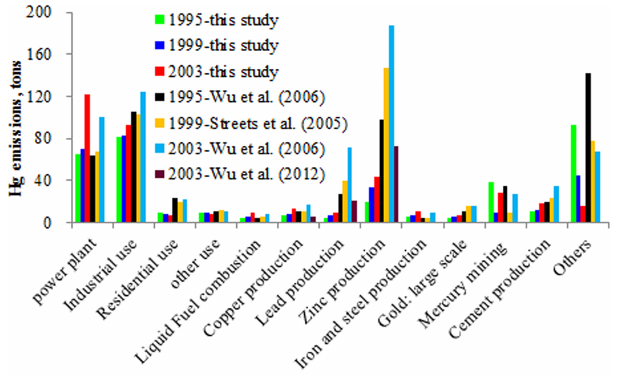
Figure 3. Estimate of annual Hg emissions from primary anthro- pogenic sources among various studies (tyr − 1 )